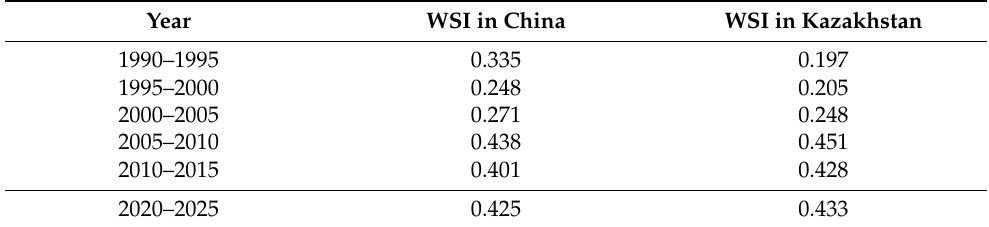
Table 4. WSI of the study area with virtual water